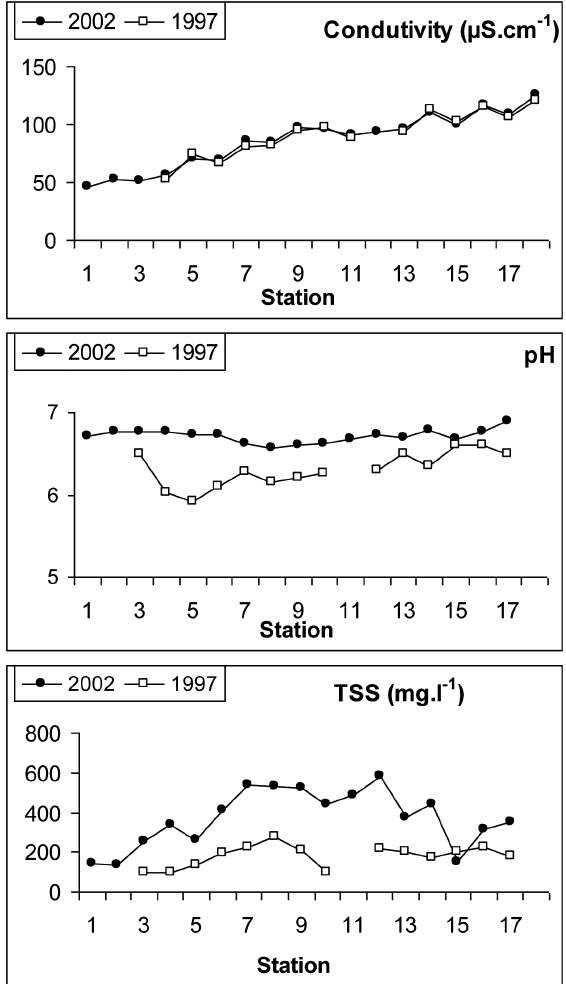
Figure 2. Hydrochemistry of the Madeira River from Porto Velho (stations 15 to 18), the middle section (14 to 5) to the confluence with the Amazon River (stations 4 to